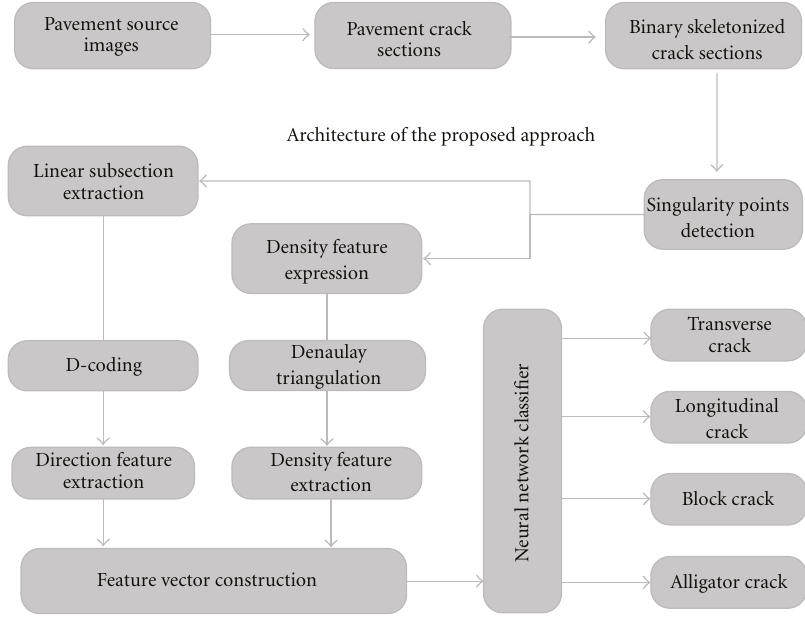
Figure 2: The architecture of the proposed